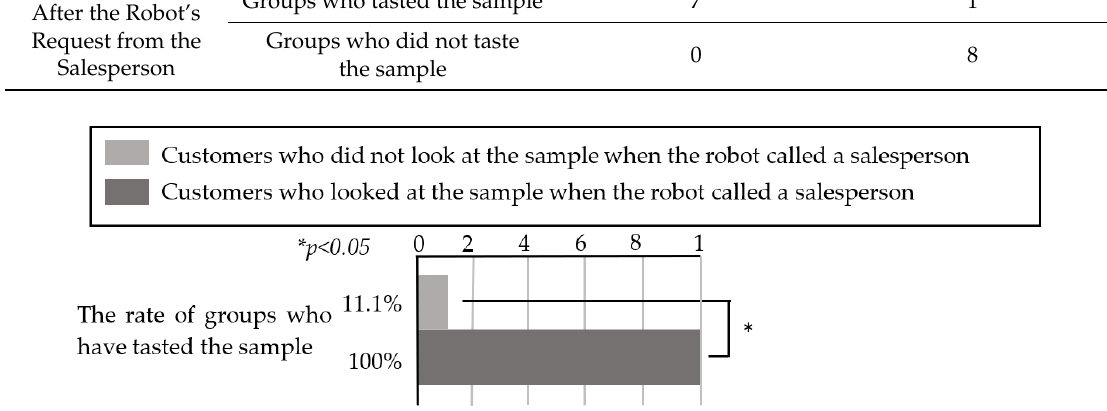
Figure 10. Rate of groups who tasted the sample when the robot called for a salesperson.